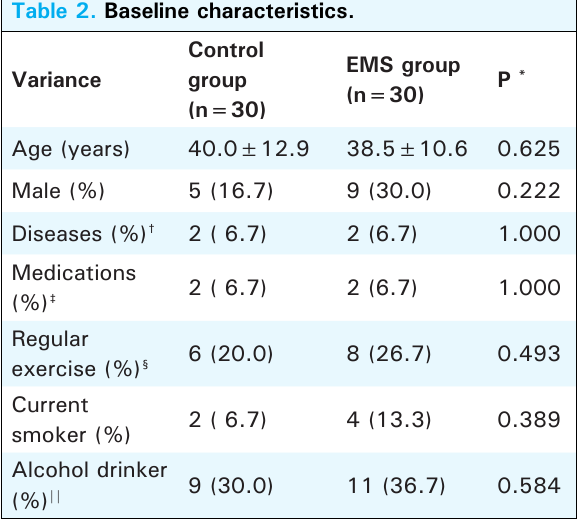
Table 2. Baseline characteristics.